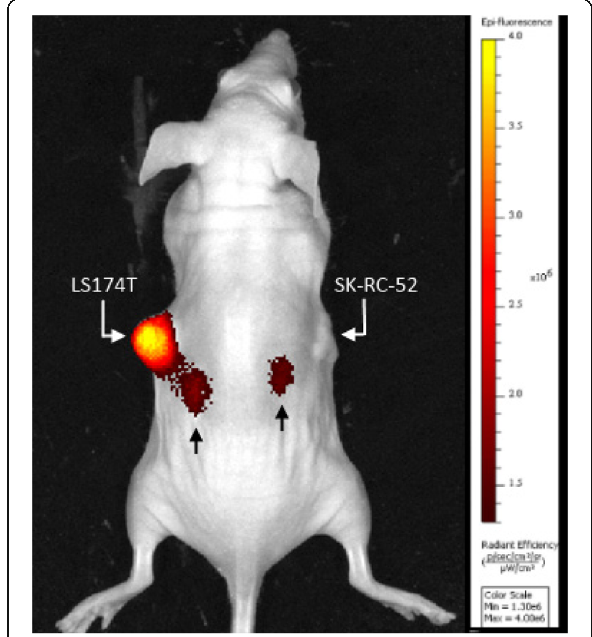
Fig. 3 Near-infrared fluorescence image 24 h p.i. of 111 In-RDC018 in a mouse bearing a s.c. CEA-expressing LS174T tumor (left flank) and a s.c. CEA-negative SK-RC-52 tumor (right flank), confirming the specific tumor targeting in the CEA-expressing tumor and renal clearance (black arrows) of 111